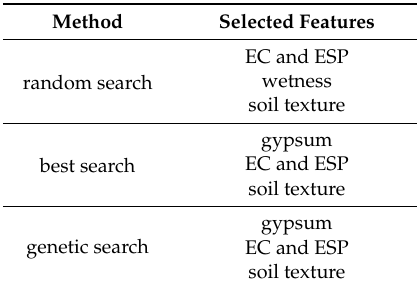
Figure 4. Land suitability map for barley using the fuzzy-AHP method (S1: high suitability, S2: moderate suitability, S3: marginal suitability, N: non-suitability). Using the feature selection methods and applying a random search on the dataset, the variables EC, ESP, wetness and soil texture were selected as inputs for the land suitability classification. With the best search algorithm and the genetic search method, EC, ESP, gypsum and soil texture were selected (Table 5).